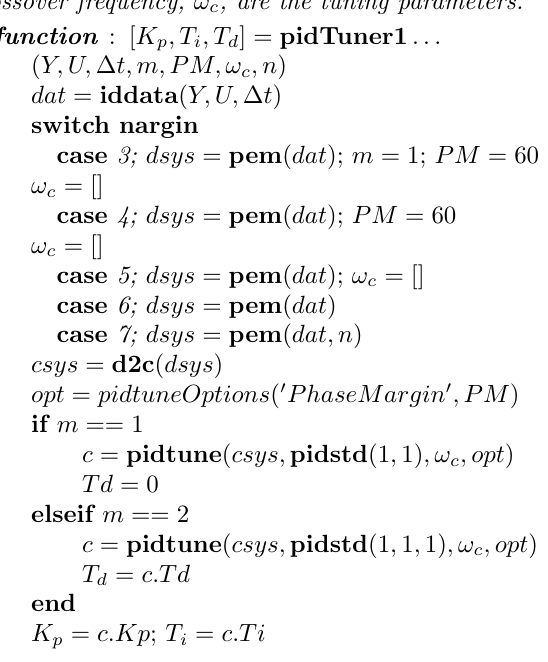
Algorithm 2 Given output and excited input data, Y and U . The following pseudocode calculates the